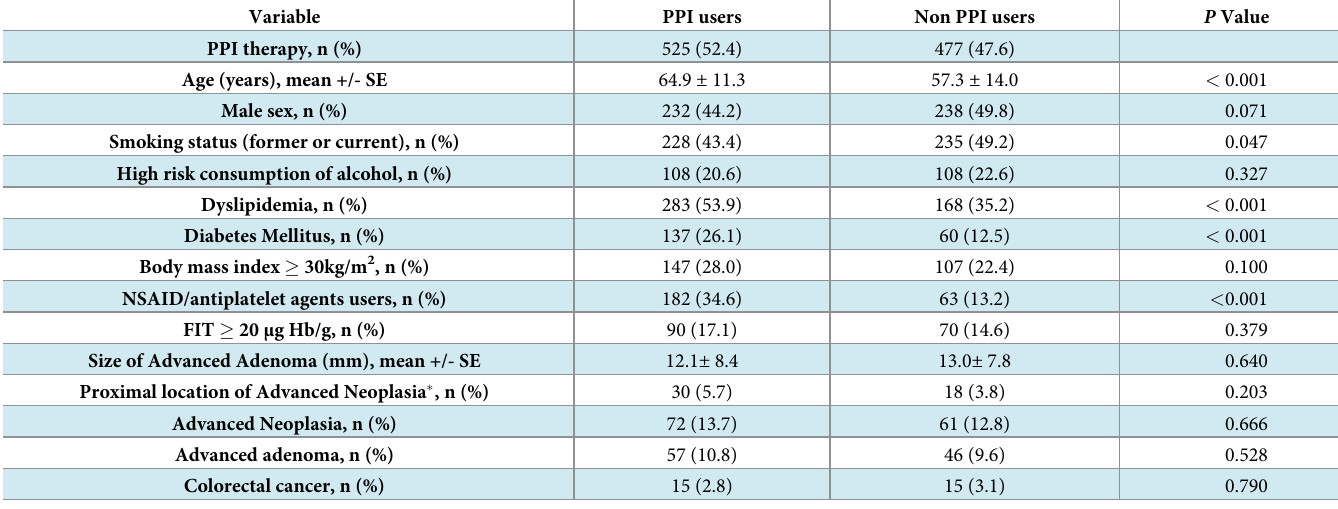
Table 1. Demographic and clinical characteristics and endoscopic findings of patients according to PPI